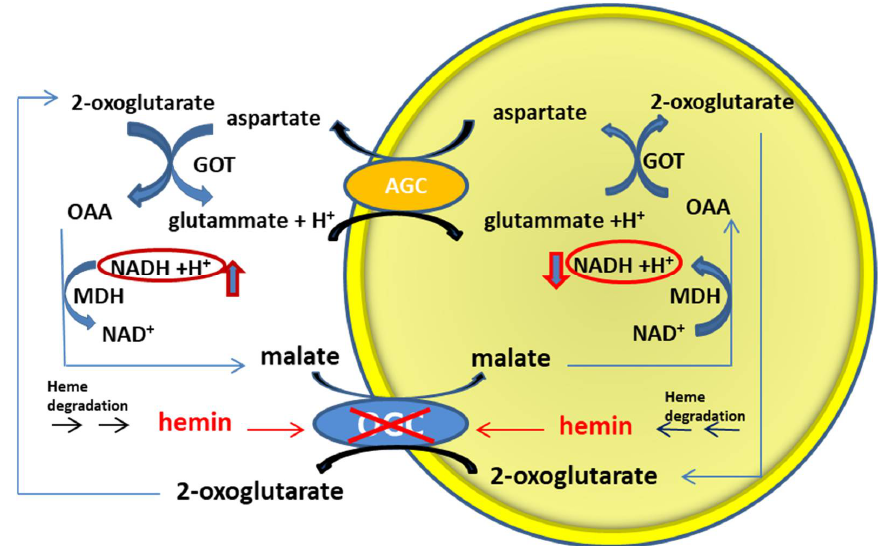
Figure 8. Malate/aspartate shuttle and the effects of hemin. The scheme represents the mitochondrial inner membrane with the components of the malate/aspartate shuttle, i.e., the OGC carrier (coded by the SLC25A11 gene) and the AGC carrier (coded by the SLC25A12/SLC25A13 genes). The presence of hemin, both inside and outside the mitochondria, derived from the degradation of porphyrin/heme pools, inhibits the OGC carrier, causing the consequent impairment of the transfer of reducing equivalents between the cytoplasm and the mitochondrial matrix.